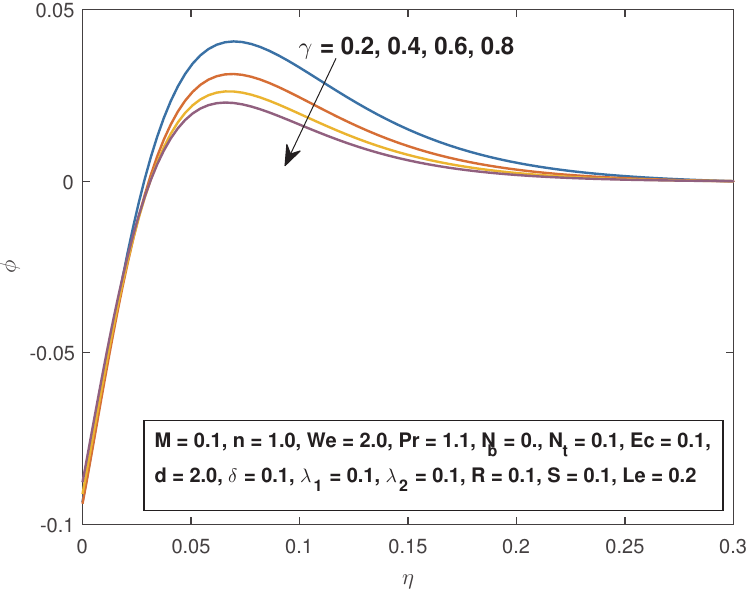
Figure 15. Influence of γ on the fluid